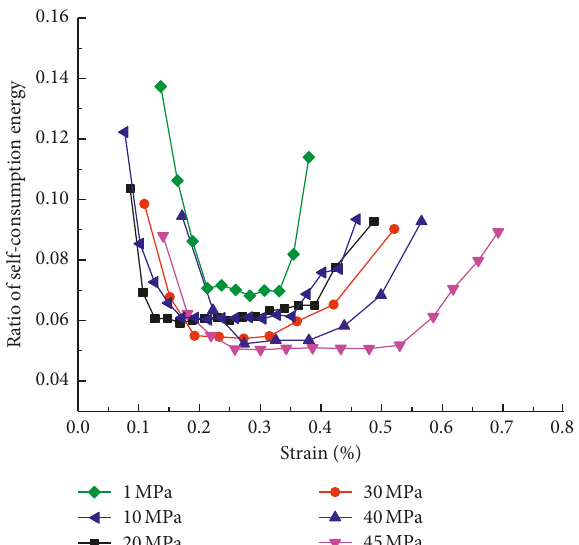
Figure 12: Variation of energy consumption.